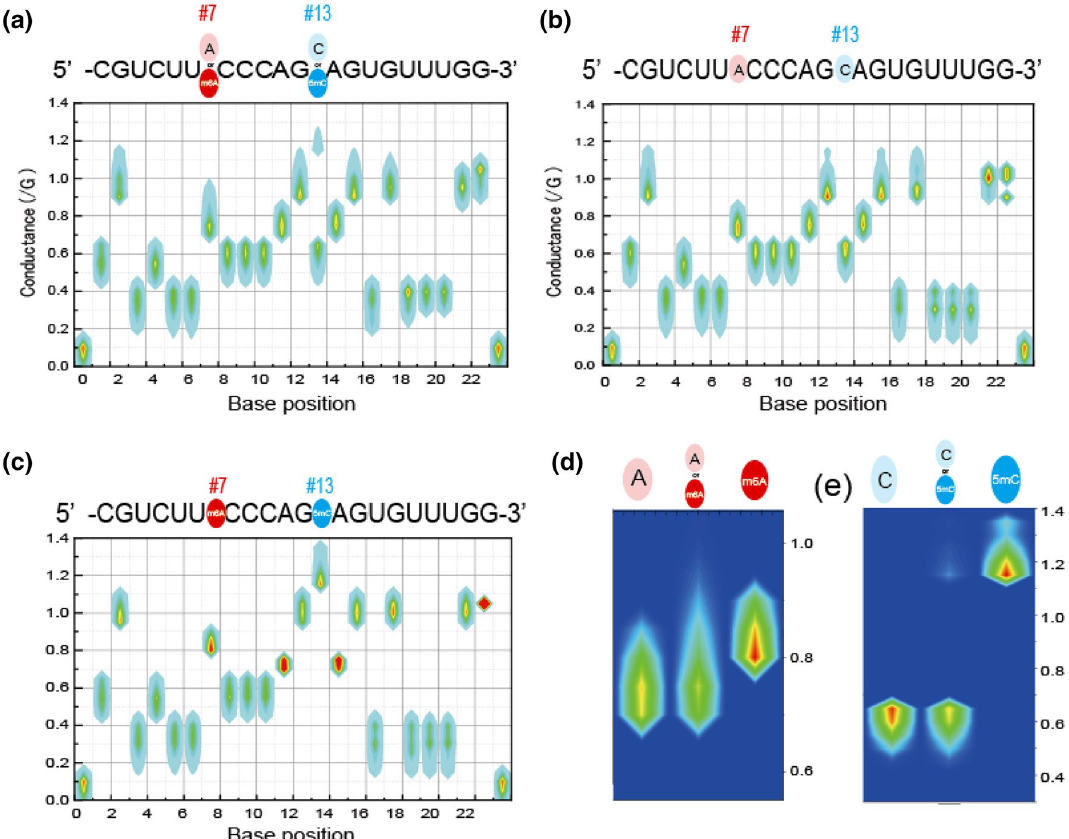
Figure 2. Determination of miR-200c-5p base sequence. ( a ) Heat maps of RNA conductance plots for miR-200c-5p extracted from colorectal cancer cells (DLD-1). ( b ) Heat maps of synthesized miR-200c-5p, in which adenosine and cytosine are non-methylated. ( c ) Heat maps of RNA conductance plots of synthesized miR-200c-5p in which adenosines #7 and #13 are methylated. The x and y axes are the base position and conductance normalized to the conductance of guanine, respectively. ( d ) Enlarged conductance plots of the #7 position adenosine for non-methylated miR-200c-5p (left), captured miR-200c-5p (middle), and methylated miR-200c-5p (right). ( e ) Enlarged conductance plots of the #13 cytidine for non-methylated miR-200c-5p (left), captured miR-200c-5p (middle), and methylated miR-200c-5p